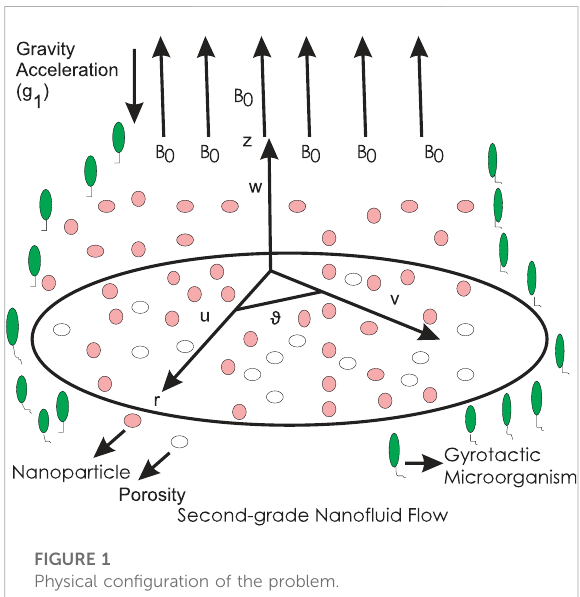
FIGURE 1 Physical con fi guration of the